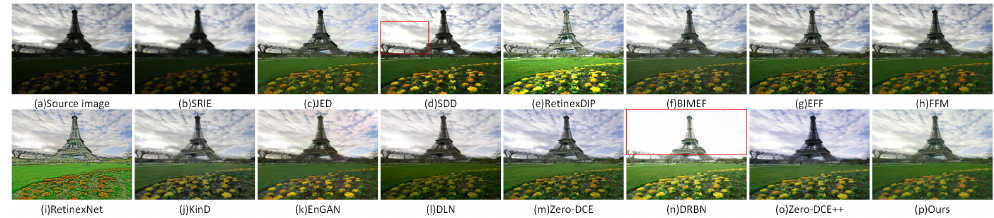
Figure 10. Comparison of the visual effects of the enhanced outdoor building images in the MEF [34]